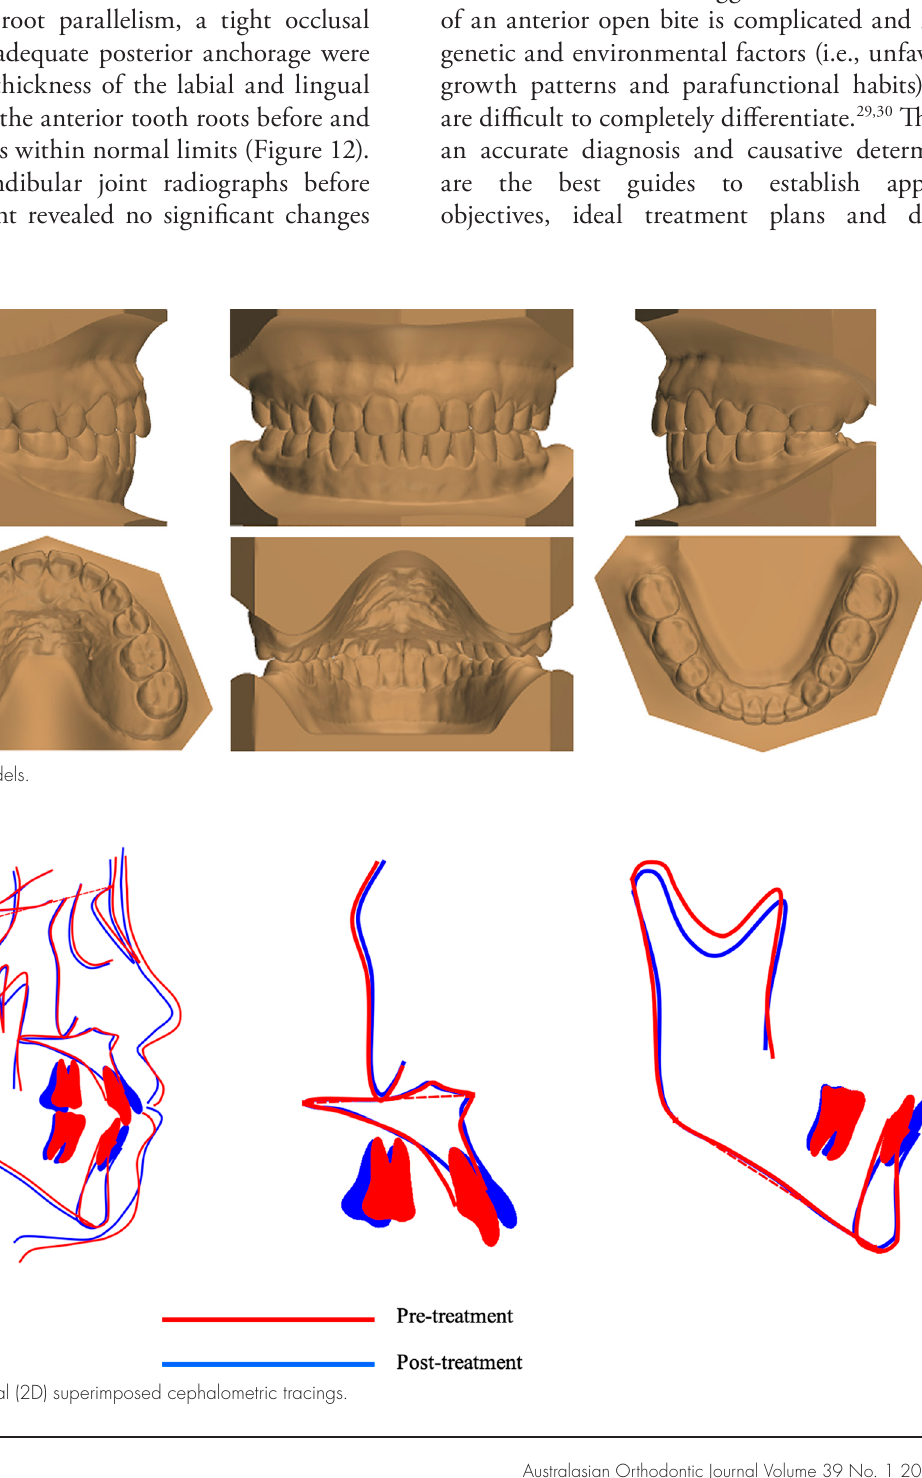
Figure 9. Two-dimensional (2D) superimposed cephalometric